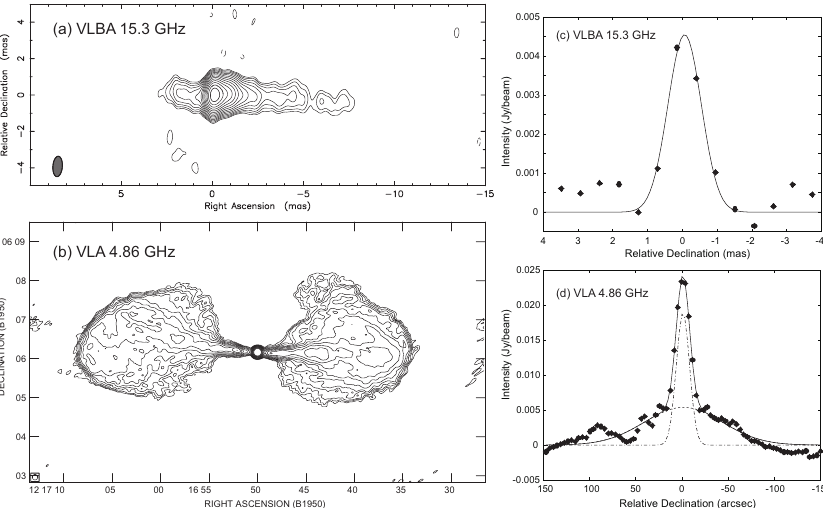
√ Figure 1. ( a ) VLBA image at 15 GHz. Contour levels are separated by factors of 2 beginning at the 3 sigma the RMS noise (1 σ = 0.358 mJy beam − 1 ); ( b ) VLA image at 5 GHz. Contour levels are √ separated by factors of 2 beginning at 3 sigma the RMS noise (1 σ = 0.395 mJy beam − 1 ); ( c ) Example of slice analysis of jet in VLBA image (15 GHz). Filled circles represent image intensity. Solid curve represents profile fitted using a Gaussian; ( d ) Example for slice analysis of jet in VLA image (5 GHz). Filled circles represent the image intensity. Dot–dashed curve represents a profile fitted to the jet component. Dashed curve represents a profile fitted to the lobe component. The solid curve represents a resultant profile of the fitted profiles of jet and lobe